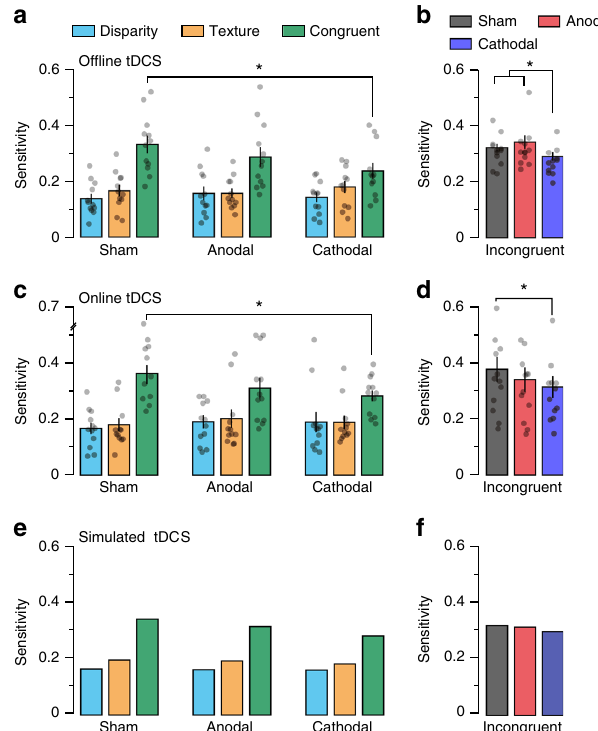
Fig. 5 Behavioural and model simulated effects of tDCS on single-(texture/ disparity), congruent- and incongruent-cue conditions. a , b Perceptual sensitivity for slant de fi ned by a single (texture/disparity), congruent and b incongruent cues following 20 min sham, anodal, and cathodal stimulation targeting V3B/KO. c , d Same as a and b but during stimulation. RM ANOVA was used to test for main effects across experimental